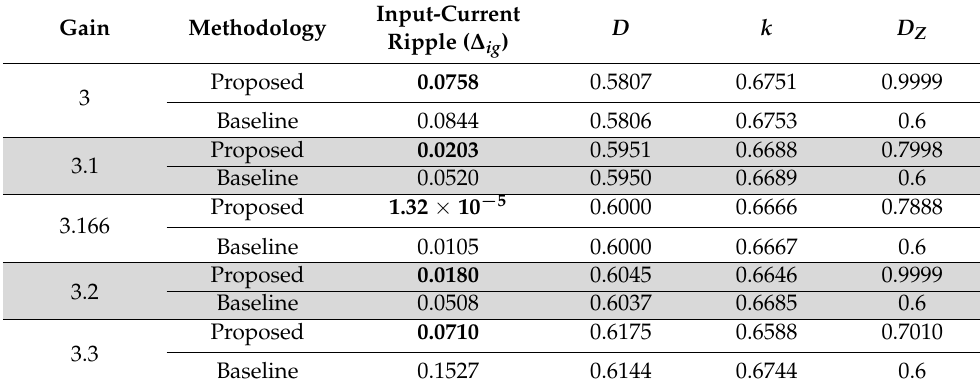
Table 2. Comparison of proposed method with baseline